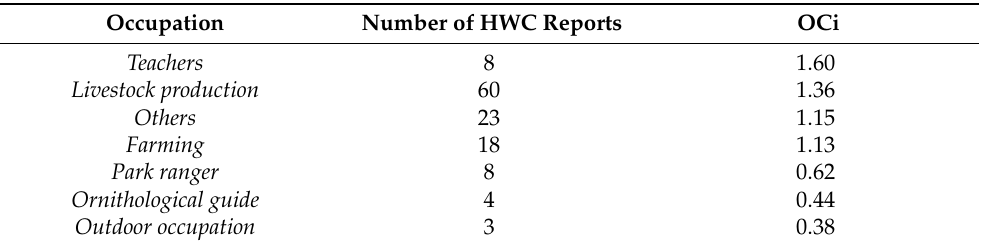
Table 3. Number of HWC reports gathered for each occupation category and conflict indices by occu-